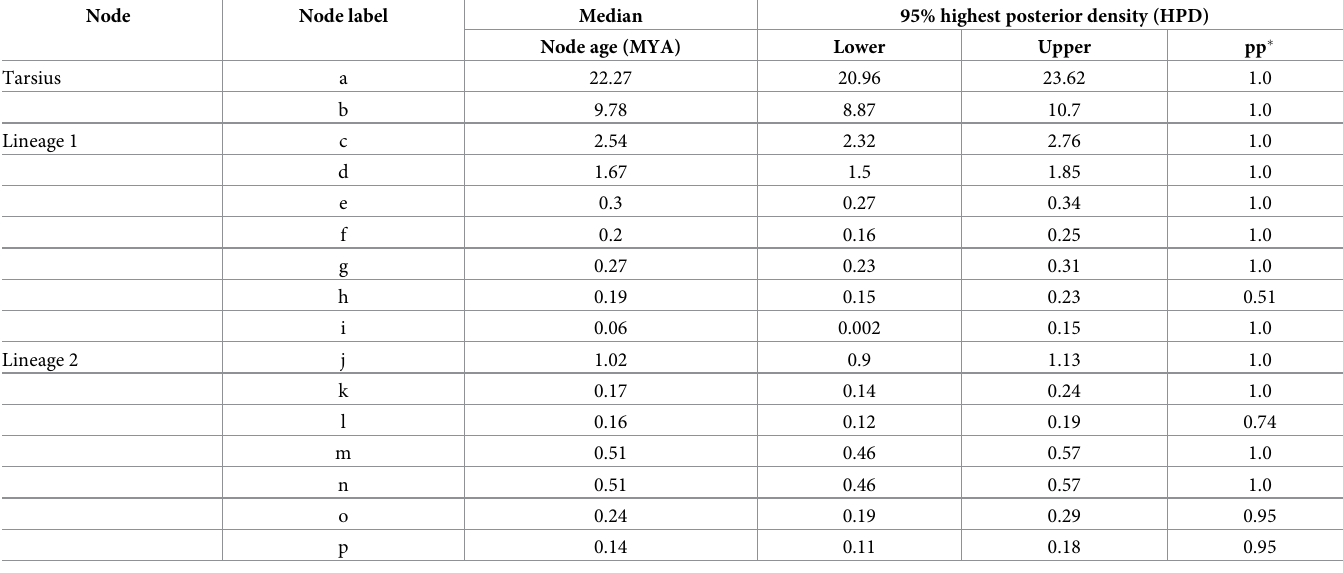
Table 3. Divergence time estimates based on a time-calibrated multilocus Bayesian tree (see Fig 5). Node Node label